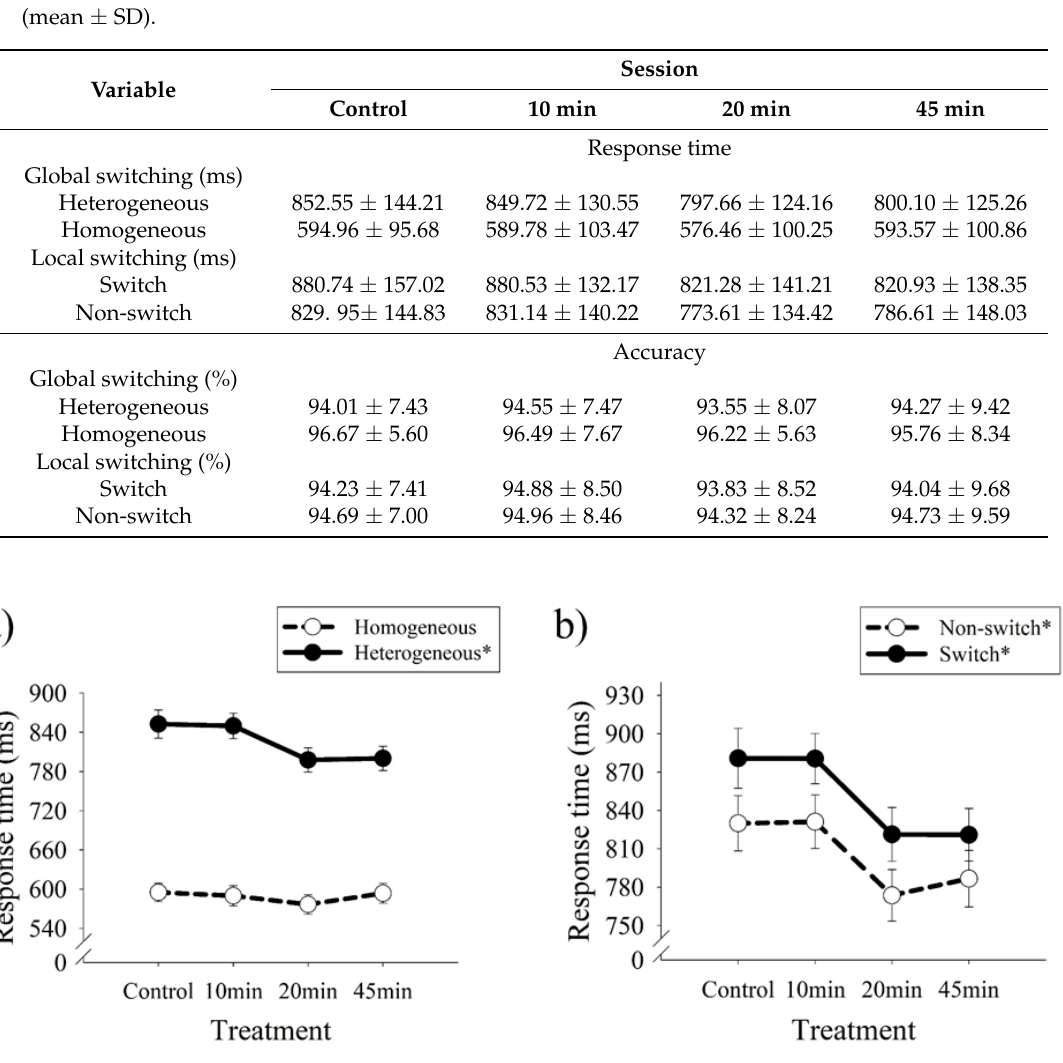
Figure 1. Dose-response relationship between exercise duration and task switching performance in response time. ( a ) Global switching; ( b ) Local switching. Note that lower scores (mean ± SEM) for response time represents better performance; * p <